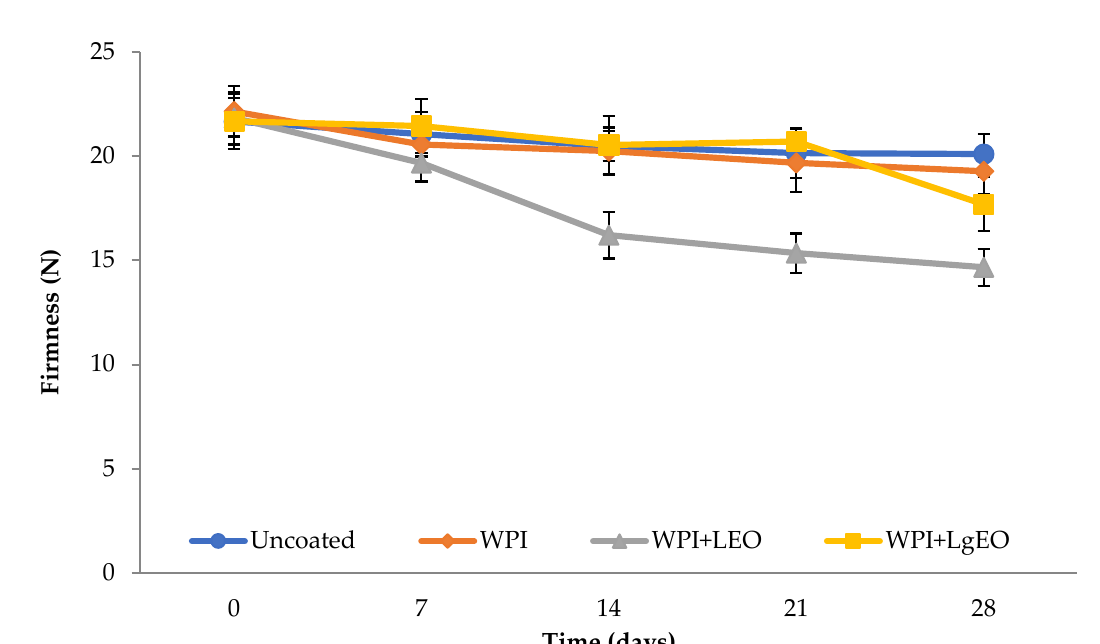
Figure 3. Firmness of fresh-cut pears coated with whey protein isolate coatings (WPI) incorporated with lemon (WPI + LEO) and lemongrass (WPI + LgEO) essential oils or uncoated samples during 28 days of storage at 4 °C.